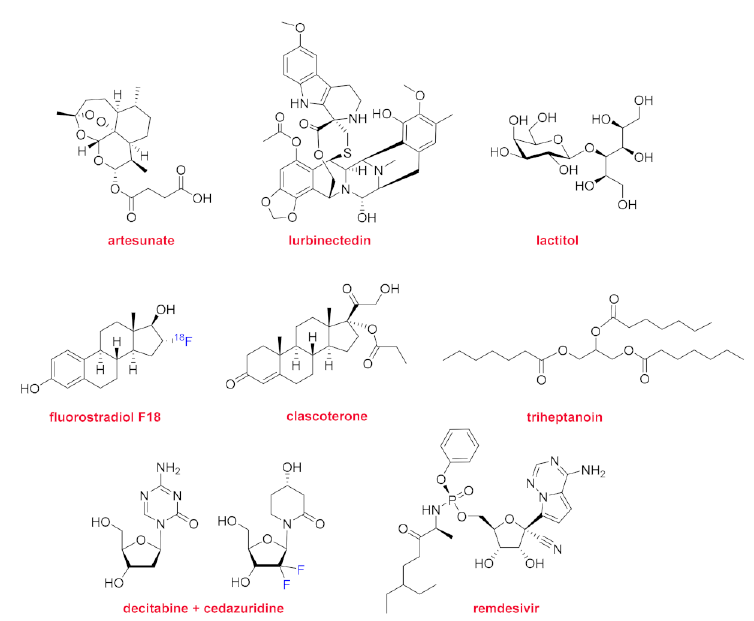
Figure 9. Structure of the natural product-based drugs (in blue fluorine